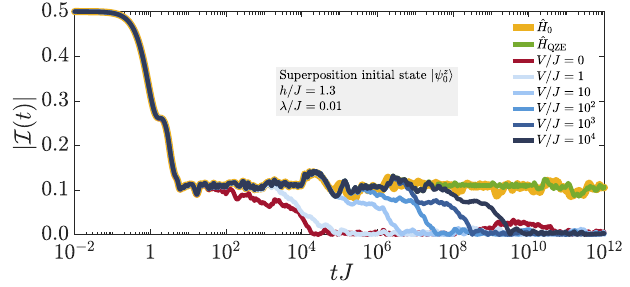
FIG. 11. Quench dynamics of imbalance (7) under ˆ H 0 + + V ˆ H = [6 ( − 1 ) j + 5] / 11. The λ ˆ H 1 G with error term (3) and c j (cid:2) ˆ protection term V ˆ H G = V c j G j does not dynamically induce j any new symmetries, but rather only protects the original Z 2 symmetry of ˆ H 0 through quantum Zeno